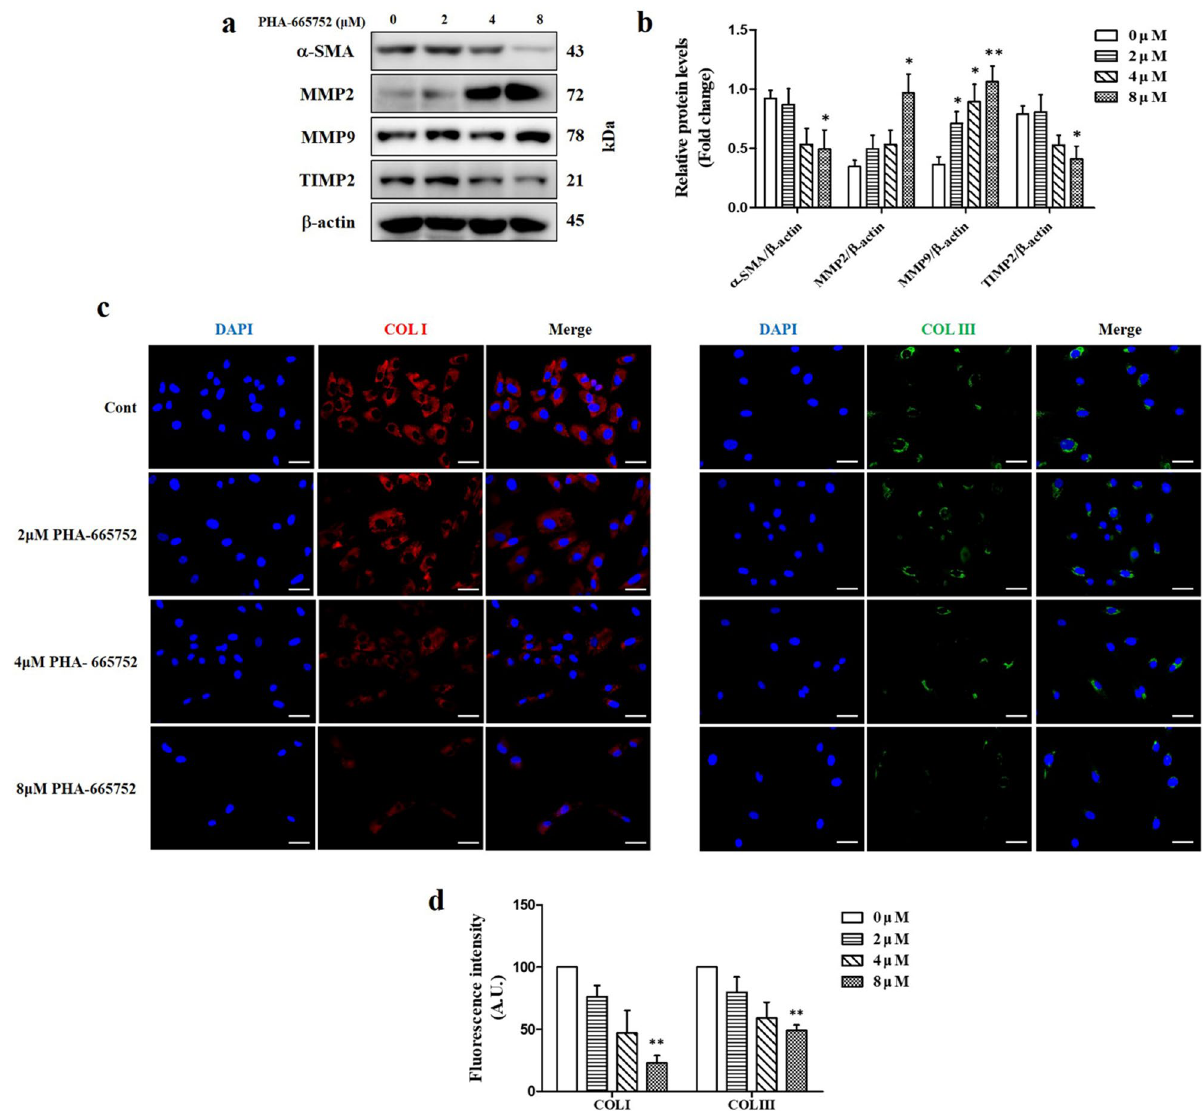
Figure 4. Effects of PHA-665752 on collagen accumulation and ECM synthesis. ( a ) Western blot analysis of the expression of α-SMA, MMP2, MMP9, and TIMP2 in keloid fibroblasts treated with PHA-665752. Full-length blot images are presented in Supplementary Fig. 4a. ( b ) The relative protein levels of α-SMA, TIMP2, MMP2, and MMP9 (*represents p < 0.05, **represents p < 0.005). ( c ) Immunofluorescence for COL I and COL III. Nuclei were stained with DAPI (blue) (original magnification: 200 × , scale bar = 50 μm). ( d ) Fluorescence intensity of COL I and COL III (**represents p < 0.005). Cont,